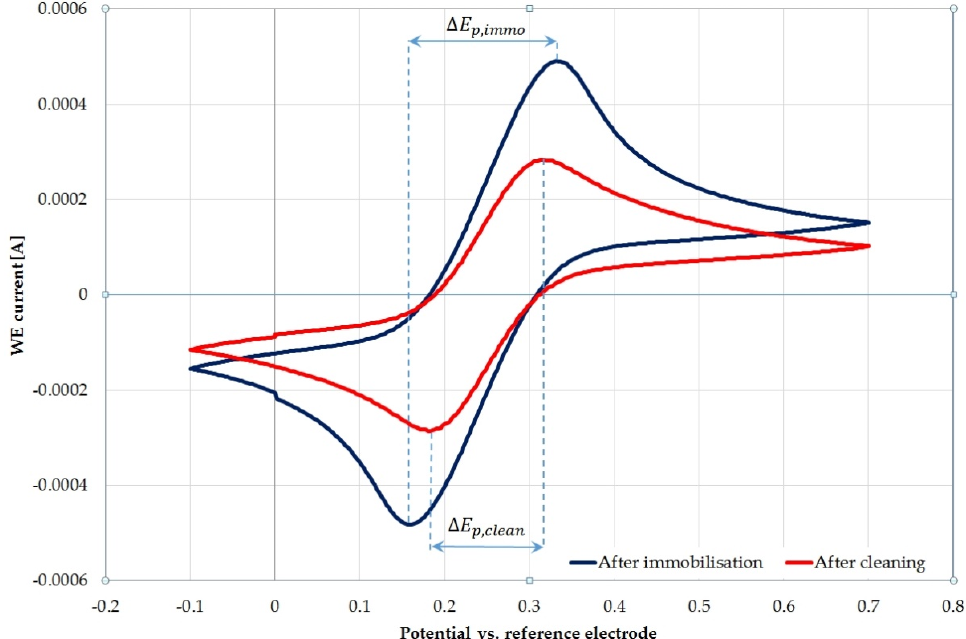
Figure 4 . Comparison of CV scans before and after potential cycling cleaning (in sulphuric acid).